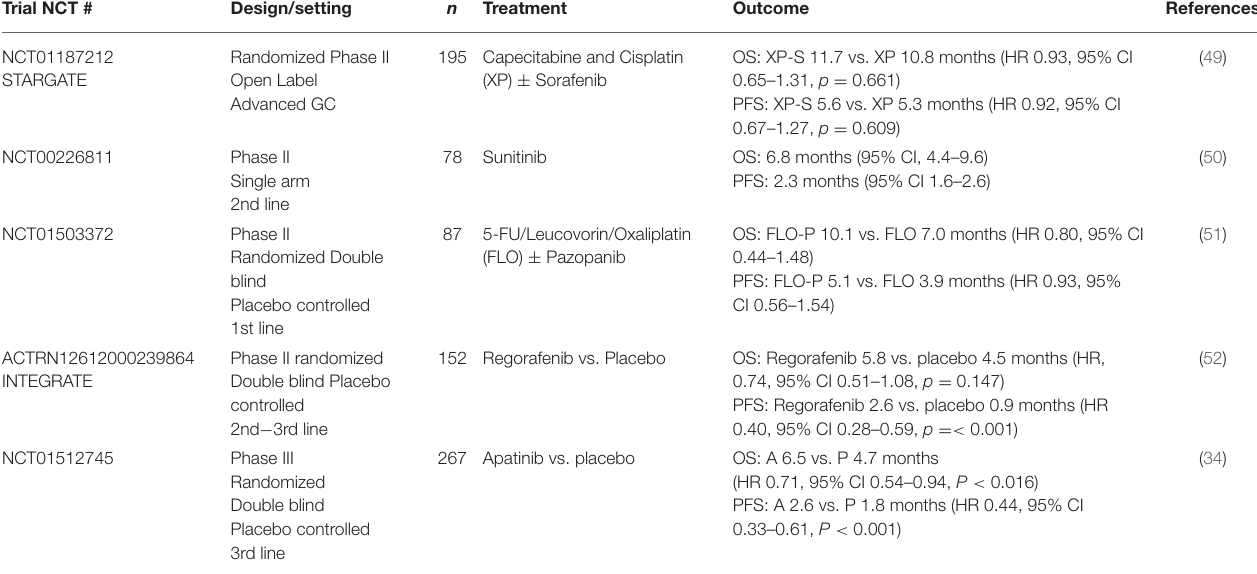
TABLE 4 | Selected studies of TKIs in gastric